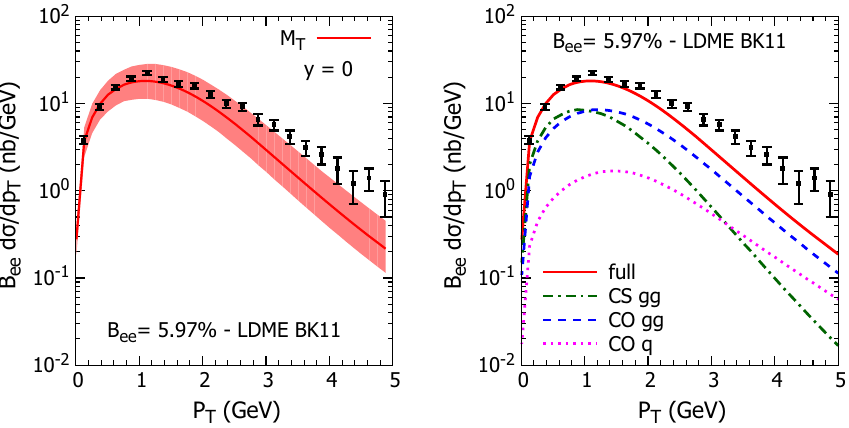
Fig. 1 Left panel: Unpolarized cross section for the process pp → Right panel: separate contributions to the full cross section (red solid √ J /ψ X , as a function of P T at s = 200 GeV and y = 0, within line) for μ = M T from the color singlet state (green dot-dashed line) the GPM approach compared with PHENIX data [41], obtained with and the color octet states for the gluon-gluon (blue dashed line), gluon- the BK11 LDME set [51]. The band represents the theoretical uncer- quark, quark-gluon and quark-antiquark (magenta dotted line) initiated tainty due to variation of the factorization scale from M T / 2 to 2 M T .